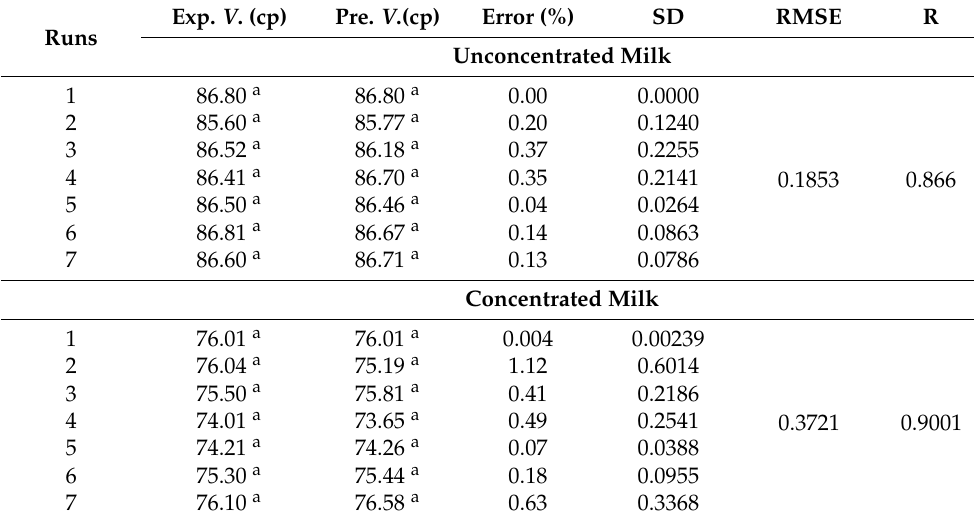
Table 6. Statistical parameters of experimental and predicted unconcentrated milk moisture content affected by color